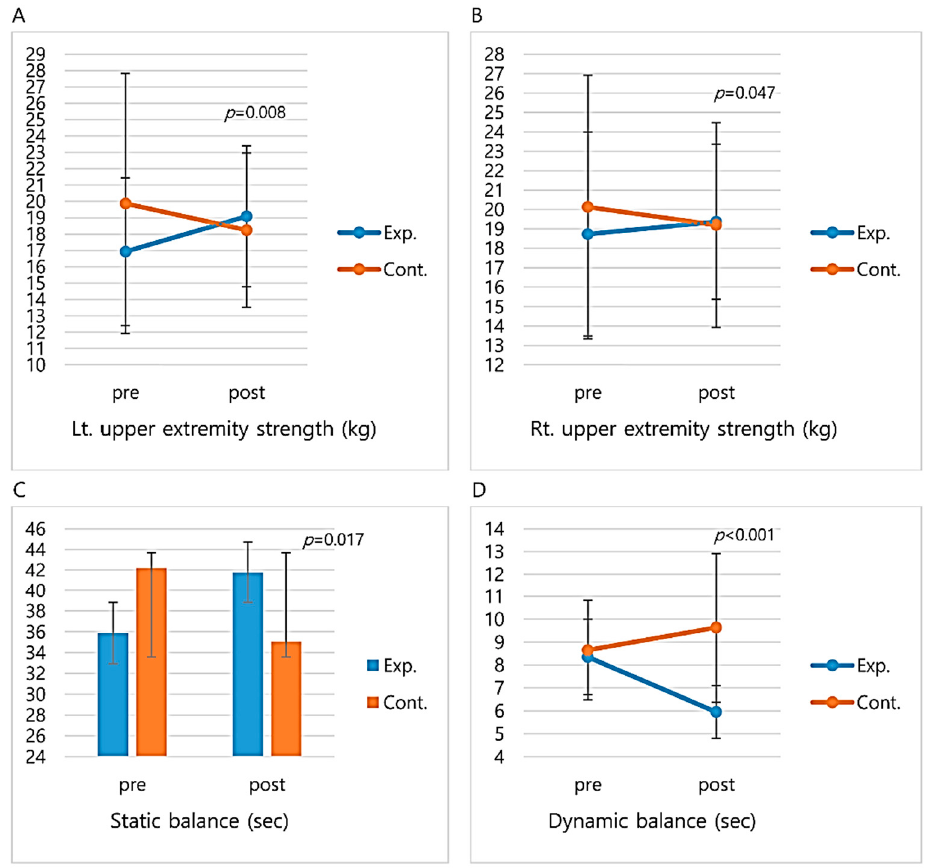
Figure 4. Comparison of physical functions before and after the integration healthcare program. ( a ) Change in Lt. upper extremity strength mean score. ( b ) Change in Rt. upper extremity strength mean score. ( c ) Change in static balance median score. ( d ) Change in dynamic balance mean score. Data represent the mean or median values, with standard deviation or interquartile range. Significance level was set to 0.05. Exp. = Experimental group; Cont. = Control group; Lt. = Left; Rt. = Right.